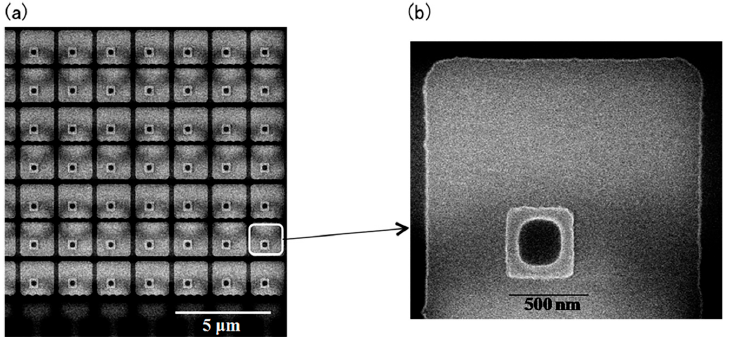
Figure 5. SEM (scanning electron microscopy) images showing ( a ) a partial view; and ( b ) a single pixel from in the 2 µm pixel pitch spin-SLM.